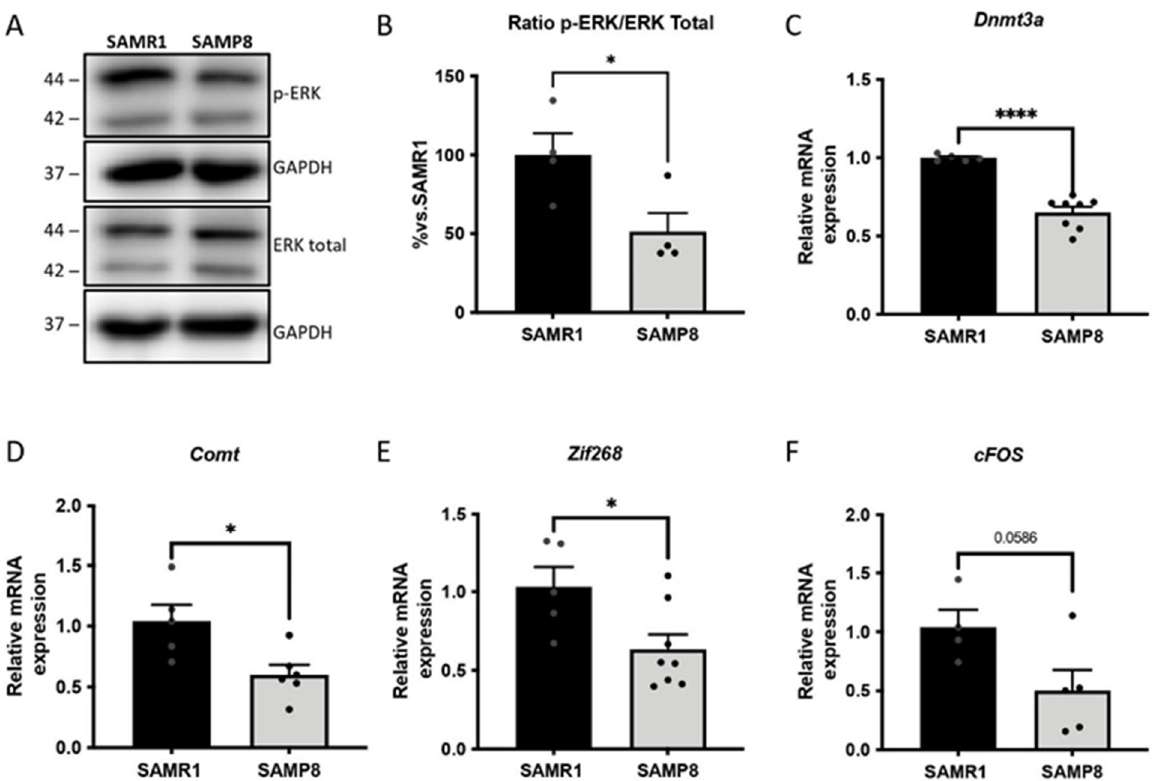
Figure 5. Representative WB ( A ) and quantification for the ratio of p-ERK/ERK total ( B ). Values in the bar graphs are adjusted to 100% for the protein levels of the SAMR1 group. Bars show the mean ± SEM; * p < 0.05. Representative gene expression levels of Dnmt3a ( C ), Comt ( D ), Zif-268 ( E ) and cFos ( F ). Gene expression levels were determined by real-time PCR. Bars show the mean ± SEM (n = 4–8 mice per group). Statistical test: t-Student analysis. * p < 0.05; **** p < 0.0001.